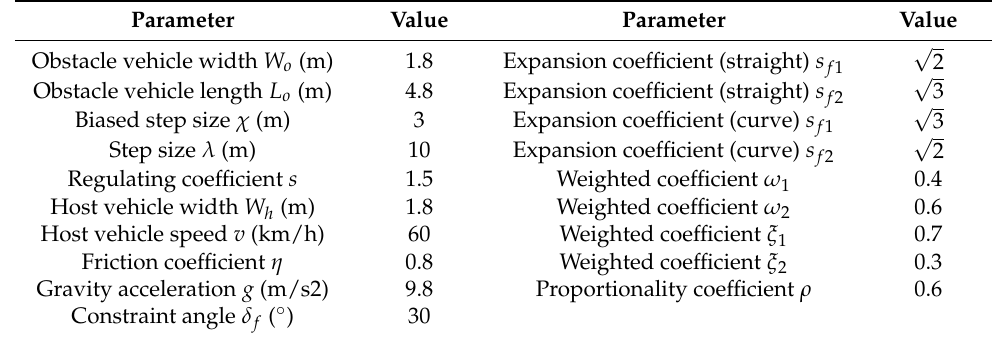
Table 2. Simulation parameters.